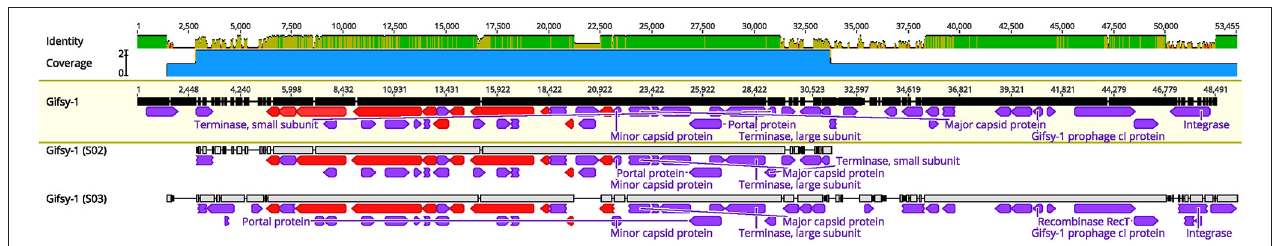
FIGURE 3 | Comparisons between Gifsy-1 and related variants in S02 and S03. ORFs in red represent tail protein regions in the respective phages. Structural proteins and lysogeny-related genes are indicated.